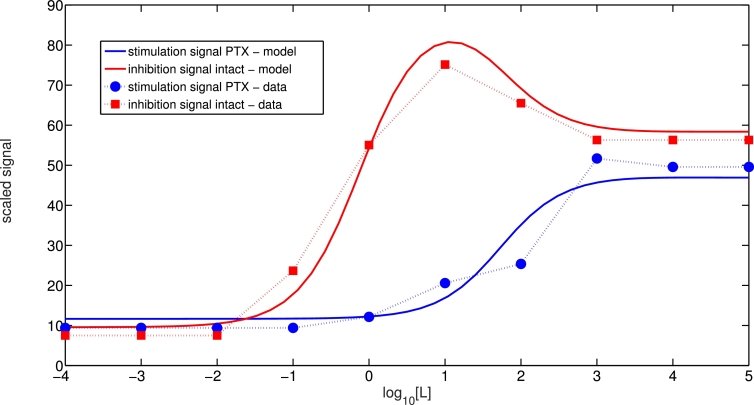
Parameter fitting for NECA experiment, using new rescaled parameter set.